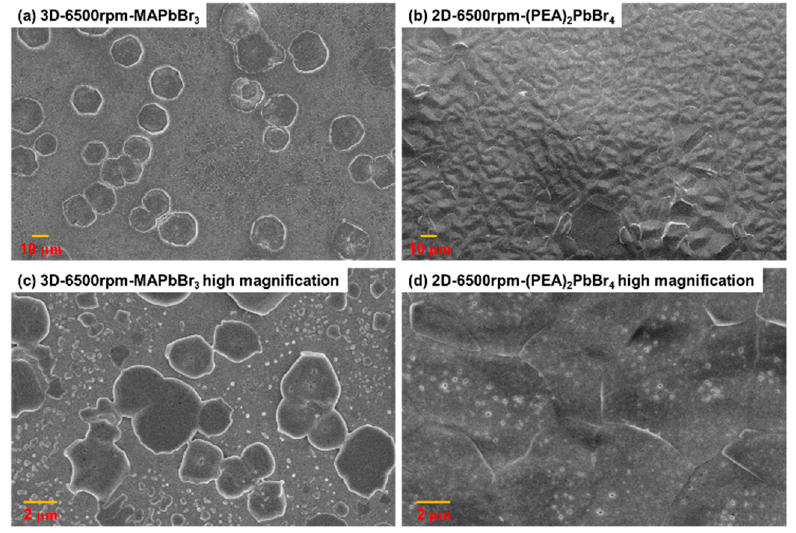
Figure 4. Low and high magnification field-emission scanning electron microscope (FESEM) images of ( a , c ) 3D-6500rpm-MAPbBr 3 and ( b , d ) 2D-6500rpm-(PEA) 2 PbBr 4 perovskites.